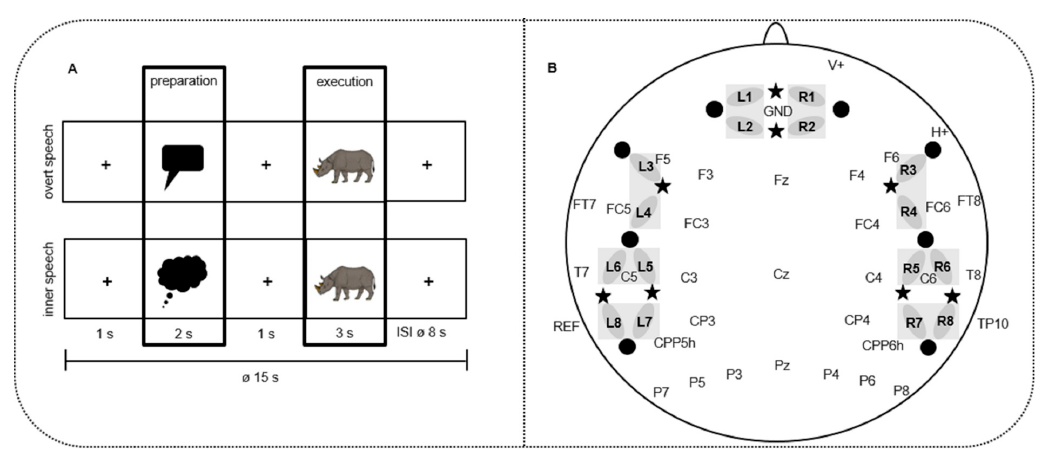
Figure 1. (A) Design of the study: event-related mini-block design. A total of 40 different colored pictures were presented twice (in inner and overt speech condition) in 16 blocks overall. Every block contained five trials of one condition. The blocks were pseudo-randomized over participants in four different versions. Each picture was cued by red speech (overt speech condition) or blue thinking (inner speech condition) bubbles. Pictures that had to be named (e.g., the rhinoceros) were taken from Rossion and Pourtois [51] with image courtesy of the authors. (B) Simultaneous electroencephalography (EEG) electrodes and functional near-infrared spectroscopy (fNIRS) channel placement. A total of 32 EEG electrodes (e.g., Cz); stars: 8 NIRS light emitters; dots: 8 NIRS detectors. L1-8:8 left NIRS channels; R1-8:8 right NIRS channels, resulting from the light emitter-detector arrangement. Grey bars indicate the regions of interest (ROIs) of the fNIRS channels that were used for statistical analyses.